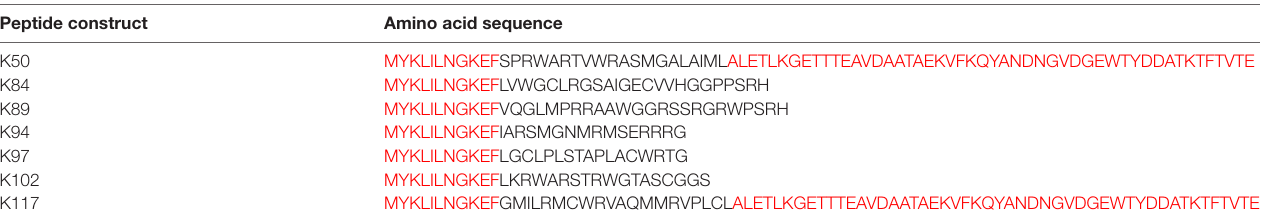
TABLE 3 | Amino acid sequences of peptides expressed in